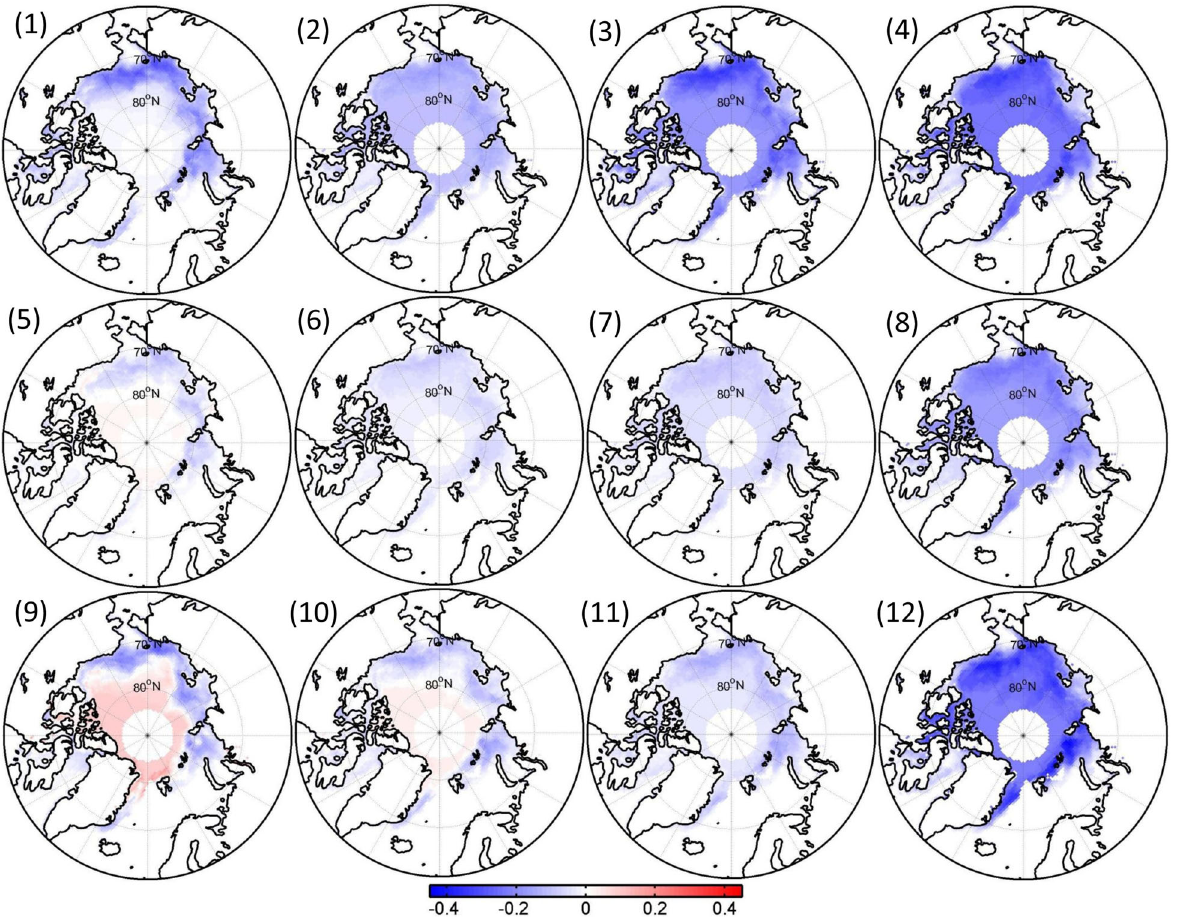
Fig. 8 Combined contribution from the dynamic, thermodynamic, and interaction components to the total trends in the August – October sea ice days from each of the 12 SOM nodes (units: day yr − 1